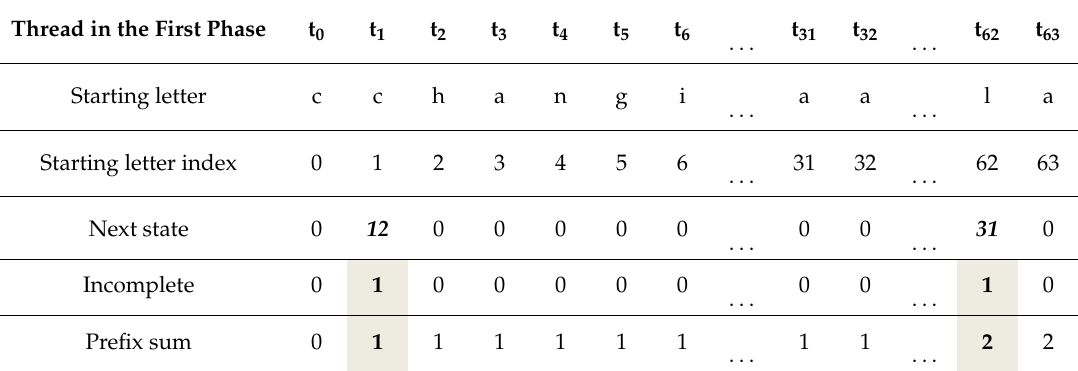
Table 4. The information about the job mapping in the first phase.